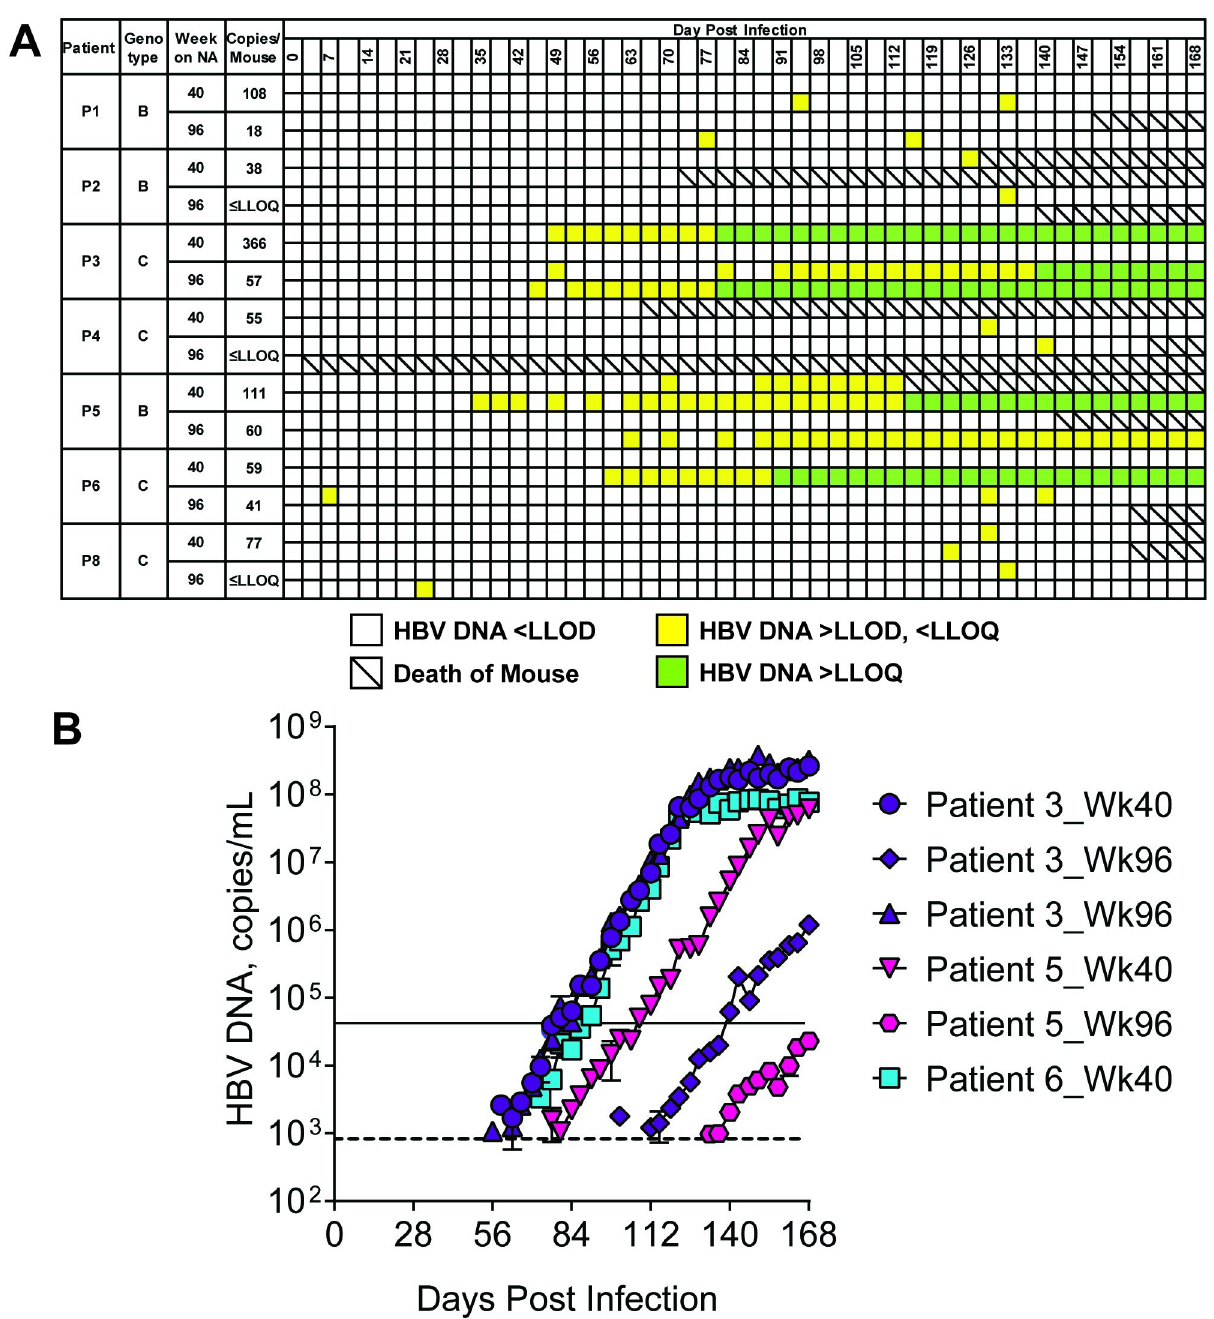
Fig 3. Patient serum near the LLOQ are infectious. Human liver chimeric mice were inoculated with 0.1 mL of sera from CHB patients from a timepoint where the HBV DNA levels were at or below the LLOQ but still TD. a, Summary of PCR results over time. Blank squares indicate HBV DNA values were < LLOD. Yellow squares indicate HBV DNA values were > LLOD but < LLOQ. Green squares indicate HBV DNA values were > LLOQ. b- d, Infectivity of a single inoculation of patient serum into mice (n = 2). HBV DNA was measured by qRT-PCR and reported as copies/mL. The dashed line represents the LLOQ (4 x 10 4 copies/mL) and the solid line represents the LLOD (8 x 10 2